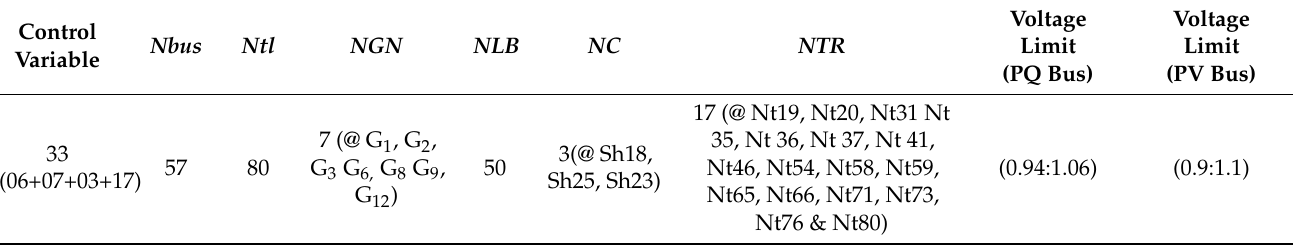
Table 10. Details of the IEEE 57-bus